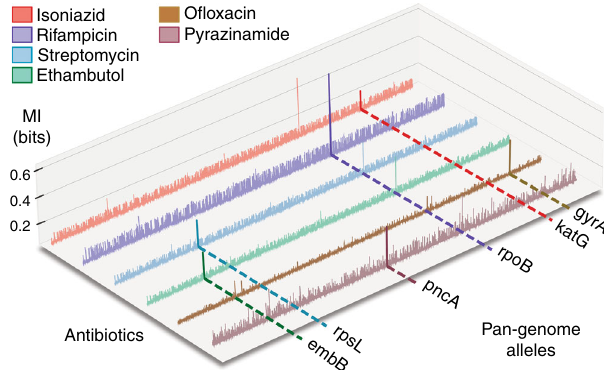
Fig. 1 Identi fi cation of key resistance-conferring genes using mutual information. The pairwise mutual information (vertical axis) between the pan-genome alleles and antibiotic resistance was calculated across all possible pairs. The listed genes correspond to the pan-genome alleles that hold the most information about the listed drug ’ s AMR